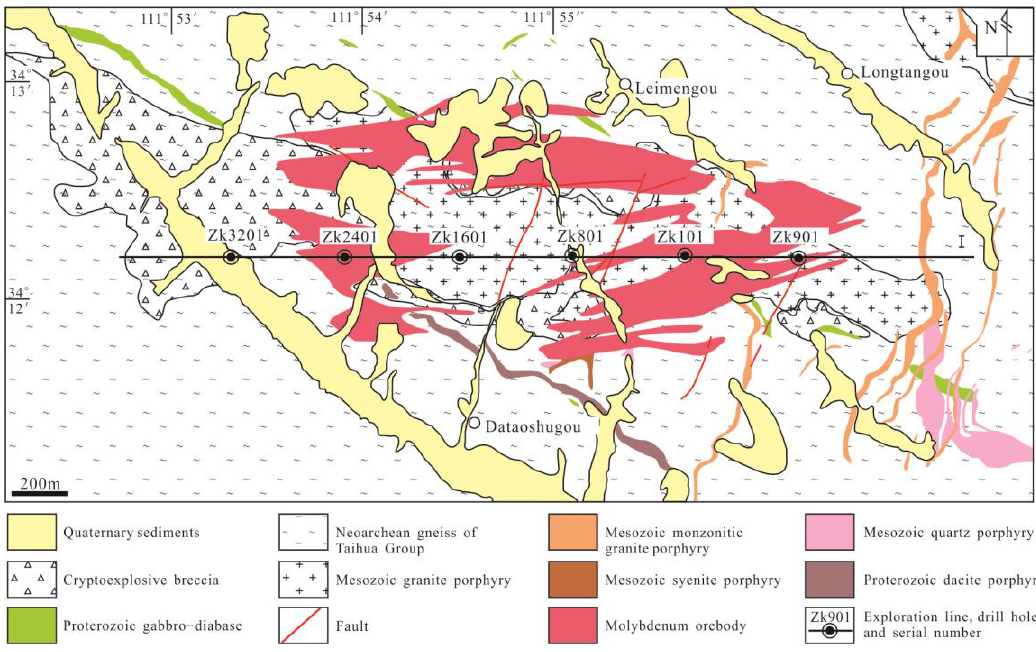
Figure 2. Geological sketch map of Leimengou Mo deposit (after Chen et al., 2011 [8]).